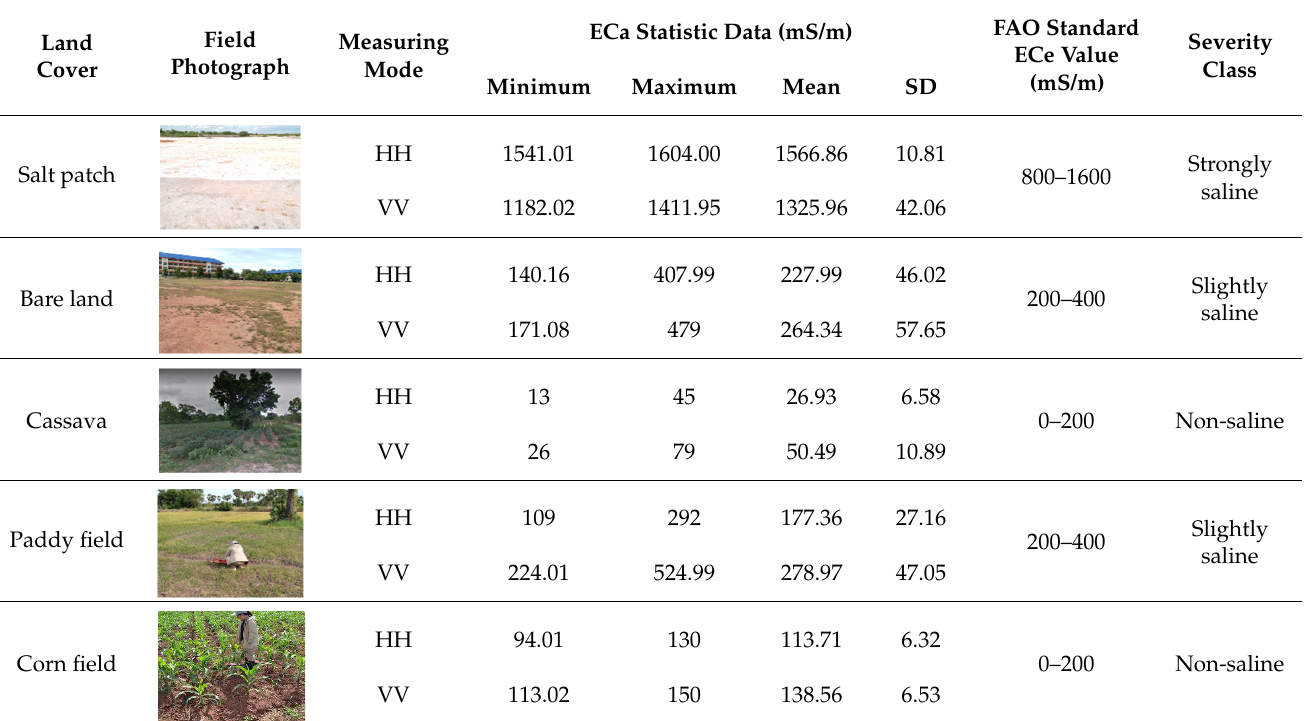
Table 4. Statistical data of the measured ECa values of HH and VV modes in five land use types. Cover